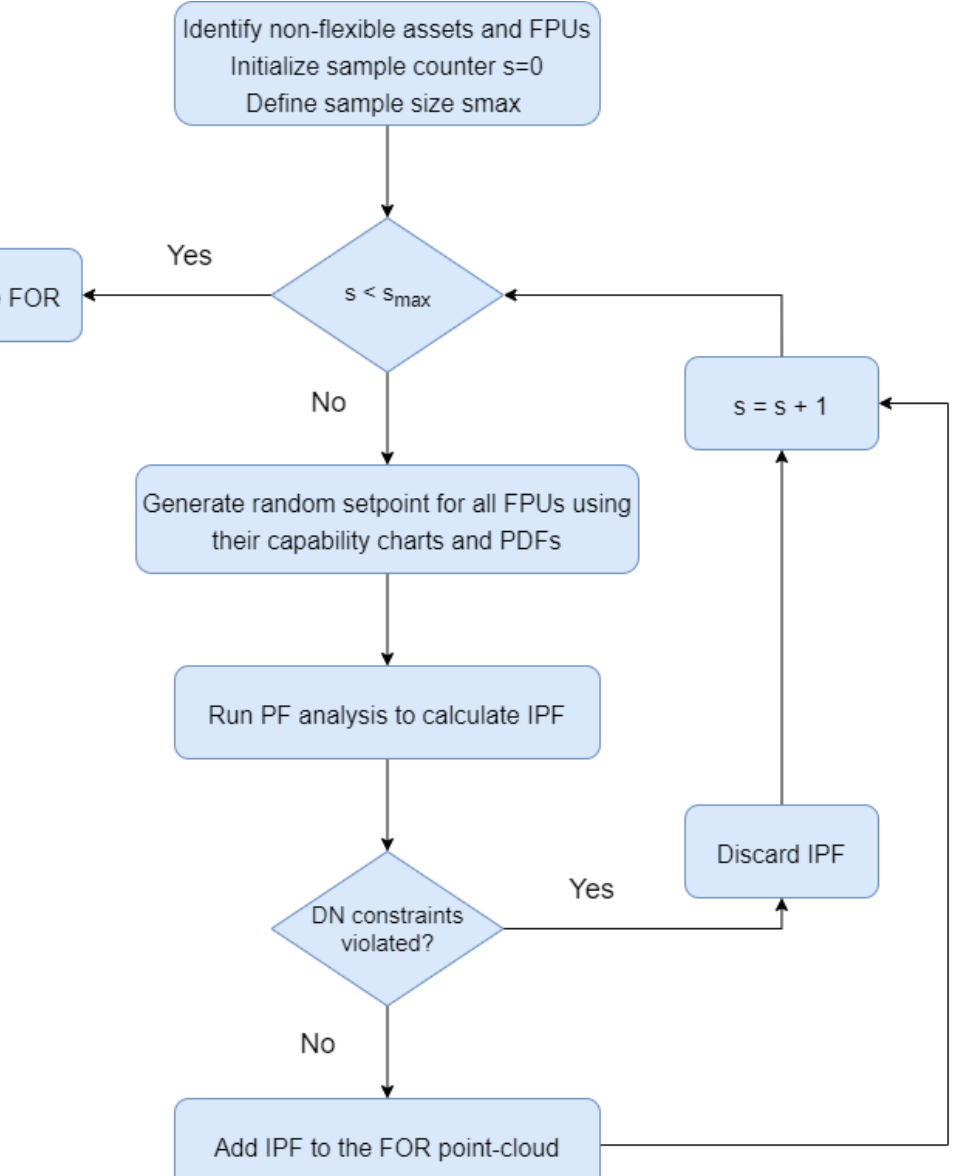
Figure 5. Flow chart of summary of RS methods.